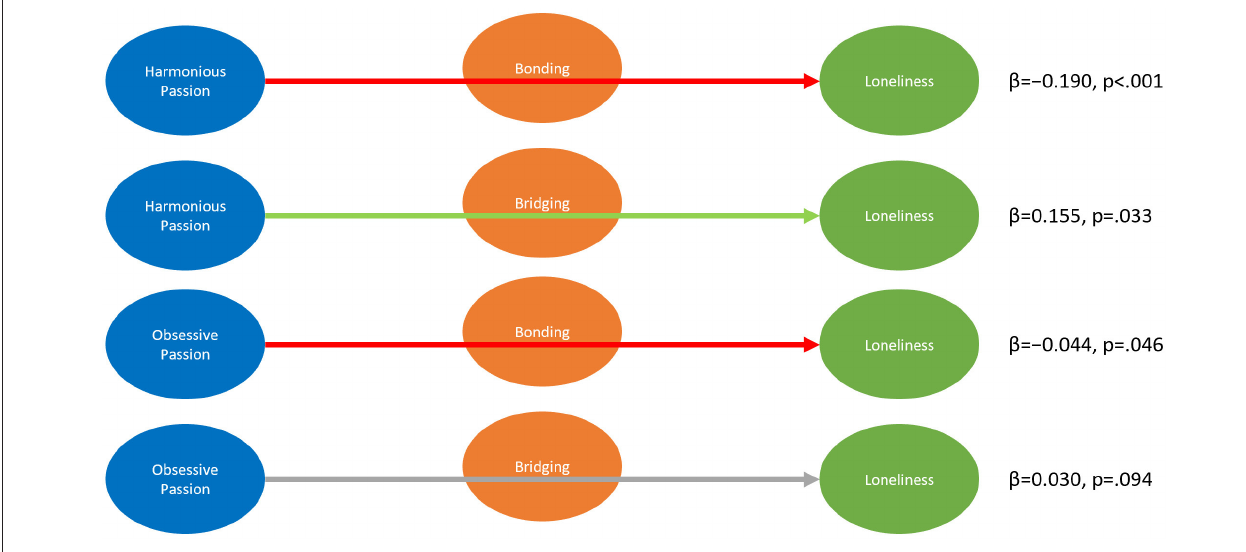
FIGURE 4 | Indirect Effects from Passion on Loneliness mediated by Social Capital. β denotes unstandardized coefficients.